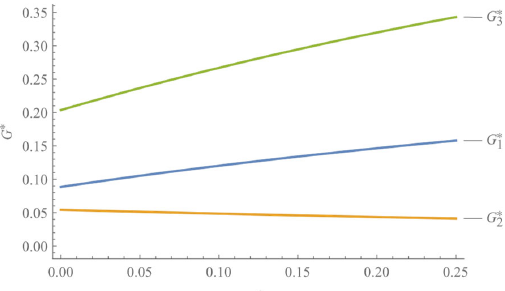
Fig. 2. The impact of manufacturer’s risk aversion on the government expenditure